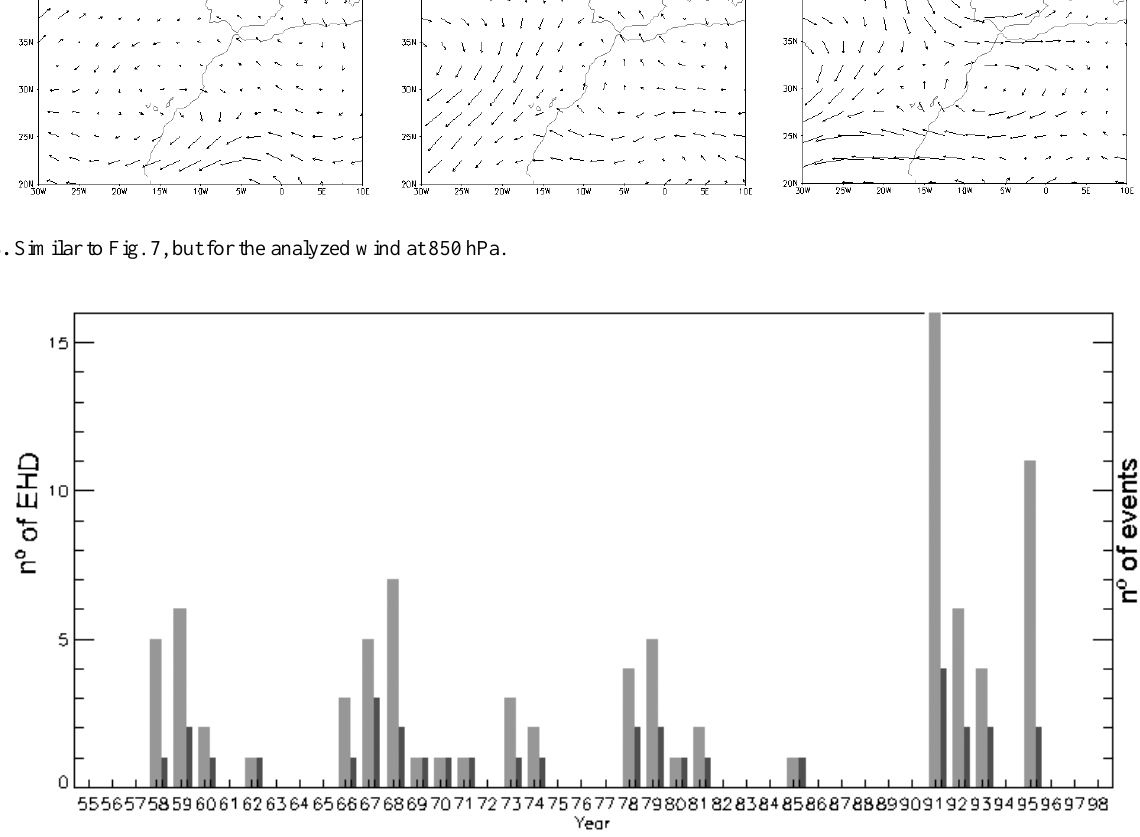
Fig. 9. Annual frequency of EHD (grey) and EH events (black) for the 1955–1998 study